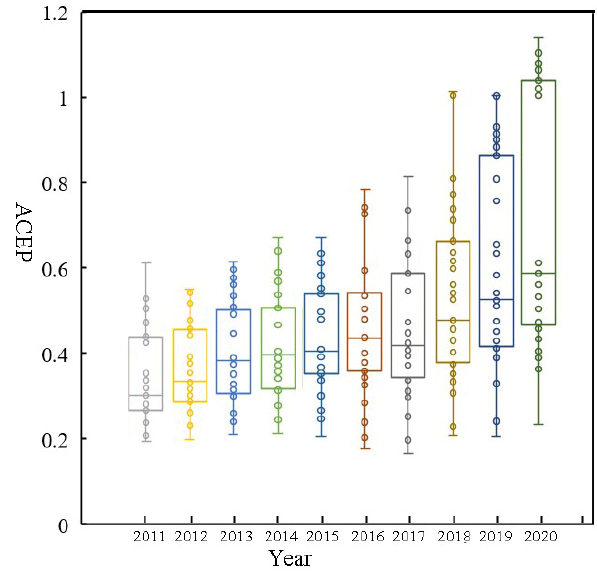
Figure 3. Box diagram of ACEP by the province between 2011 and 2020.